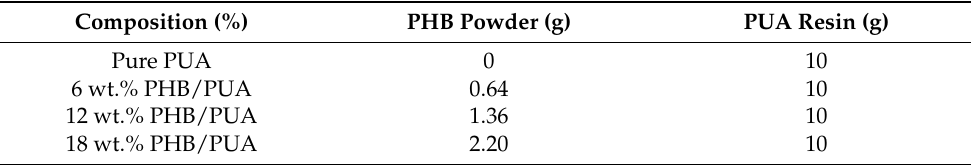
Table 1. Different compositions of PHB incorporated into PUA-based